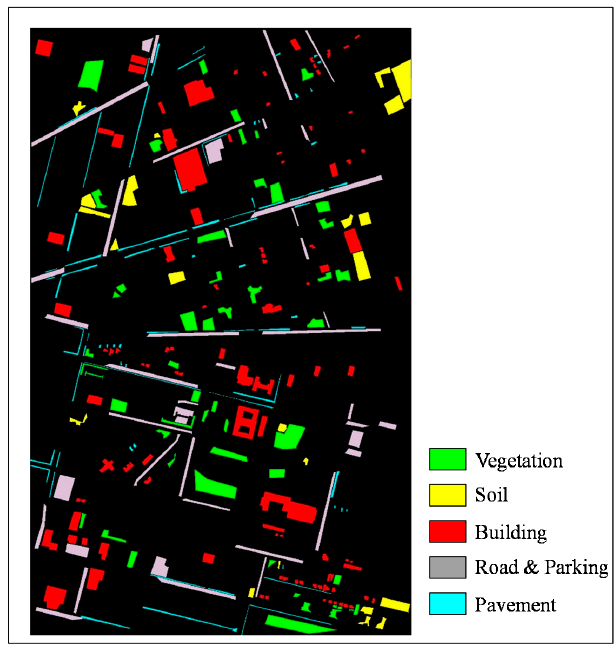
Figure 15. Reference map for the high-resolution image taken in 2011. The legends indicate the colors in the